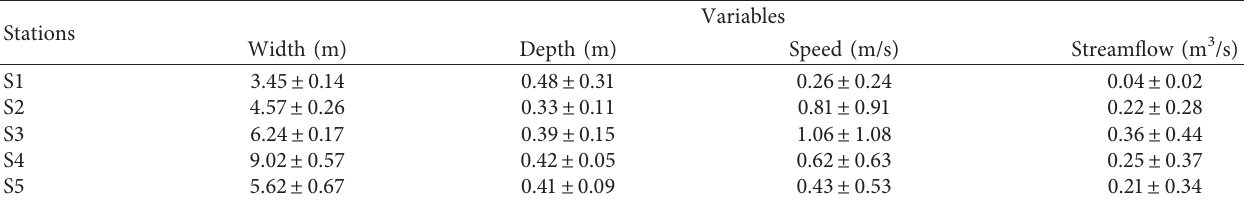
Table 4: Mean values and standard deviation of hydromorphological variables measured at the five sampling stations during the study period. Stations